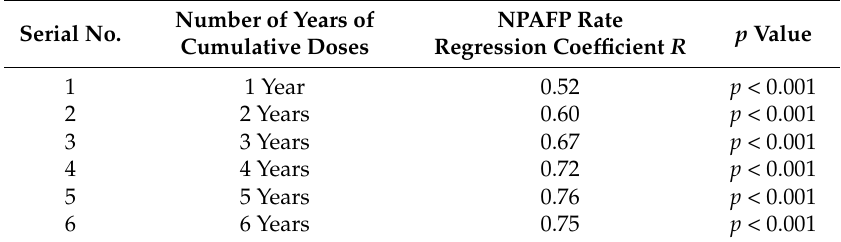
Table 1. Correlation of non-polio acute flaccid paralysis (NPAFP) rate to cumulative doses of OPV employed over six years in Uttar Pradesh (UP) and